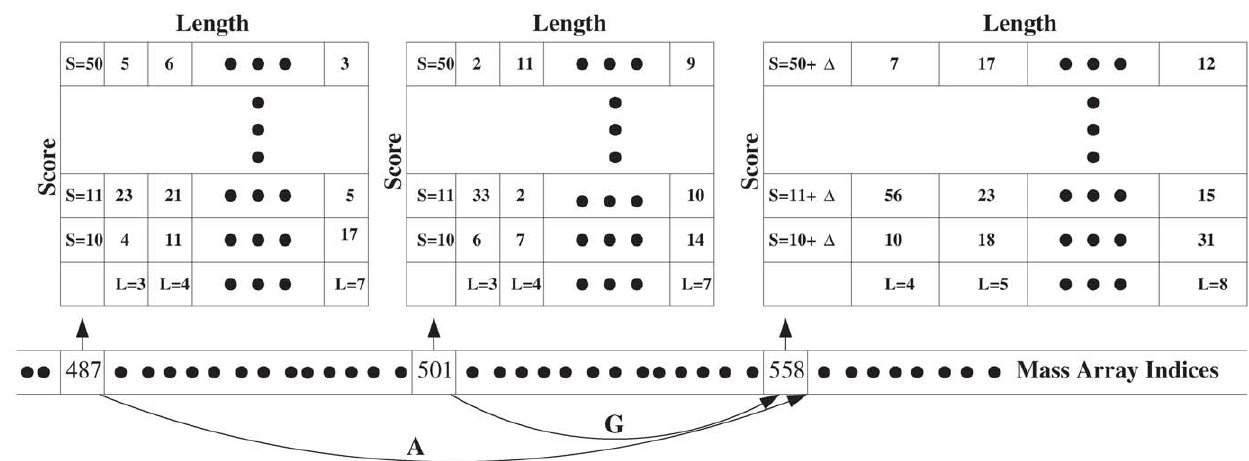
Figure 1. Illustration of APP mass grid with internal structure. In addition to show the basic mass grid, this figure illustrates,using the peptide lengths as an example, the possibility of including additional structures in the (raw) score histogram associated with each mass index. The basic idea of obtaining the score histogram via dynamic programming is explained in the Method section. The key step to incorporate additional structure is to let the (weighted) count associated with each (raw) score be further categorized by the lengths of partial peptides reaching each mass index. In the end, one will apply the length correction factor to the raw score to obtain the real score histogram. Apparently, one may also keep track of the number of b ( y ) peaks accumulated within the raw score histogram. Again, the factorial contribution can be added at the end prior to the construction of the final score histogram.